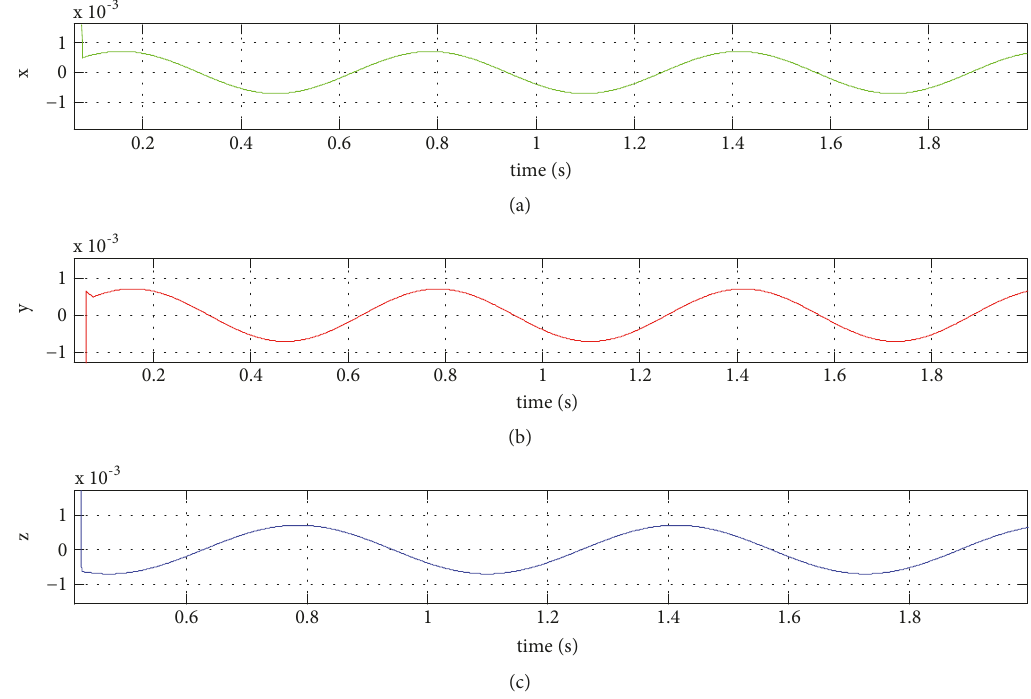
Figure 8: Zoom of Figure 7 for (a) state 𝑥 , (b) state 𝑦 , and (c) state 𝑧.